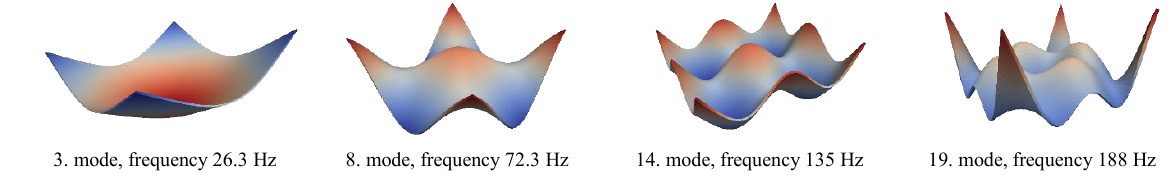
Fig. 3 Double-symmetric mode shapes and corresponding natural frequencies of the squared monolithic glass plate 10 mm thick